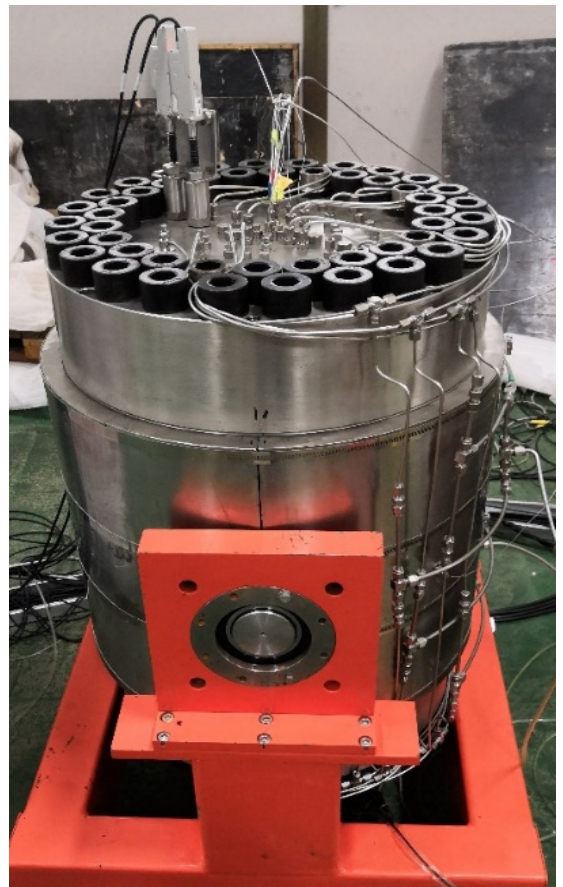
Figure 5. The sealed setup filled with water in three annuli.